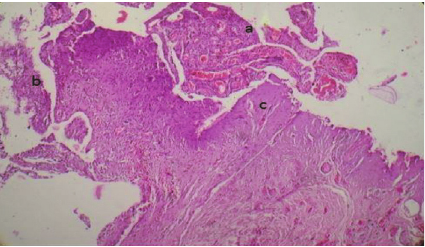
Figure 3: Perforated site ulceration showing granulation tissue (a), necrosis and chronic inflammation with activity (b), and fibrous areas